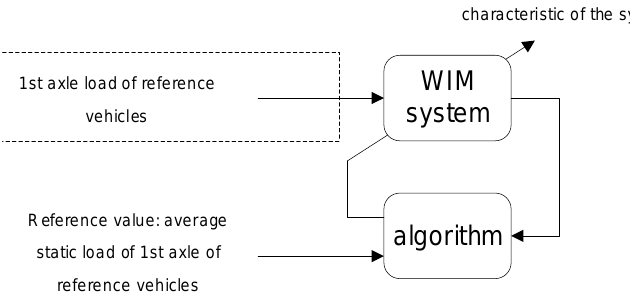
Figure 3. Idea of the autocalibration of WIM system.